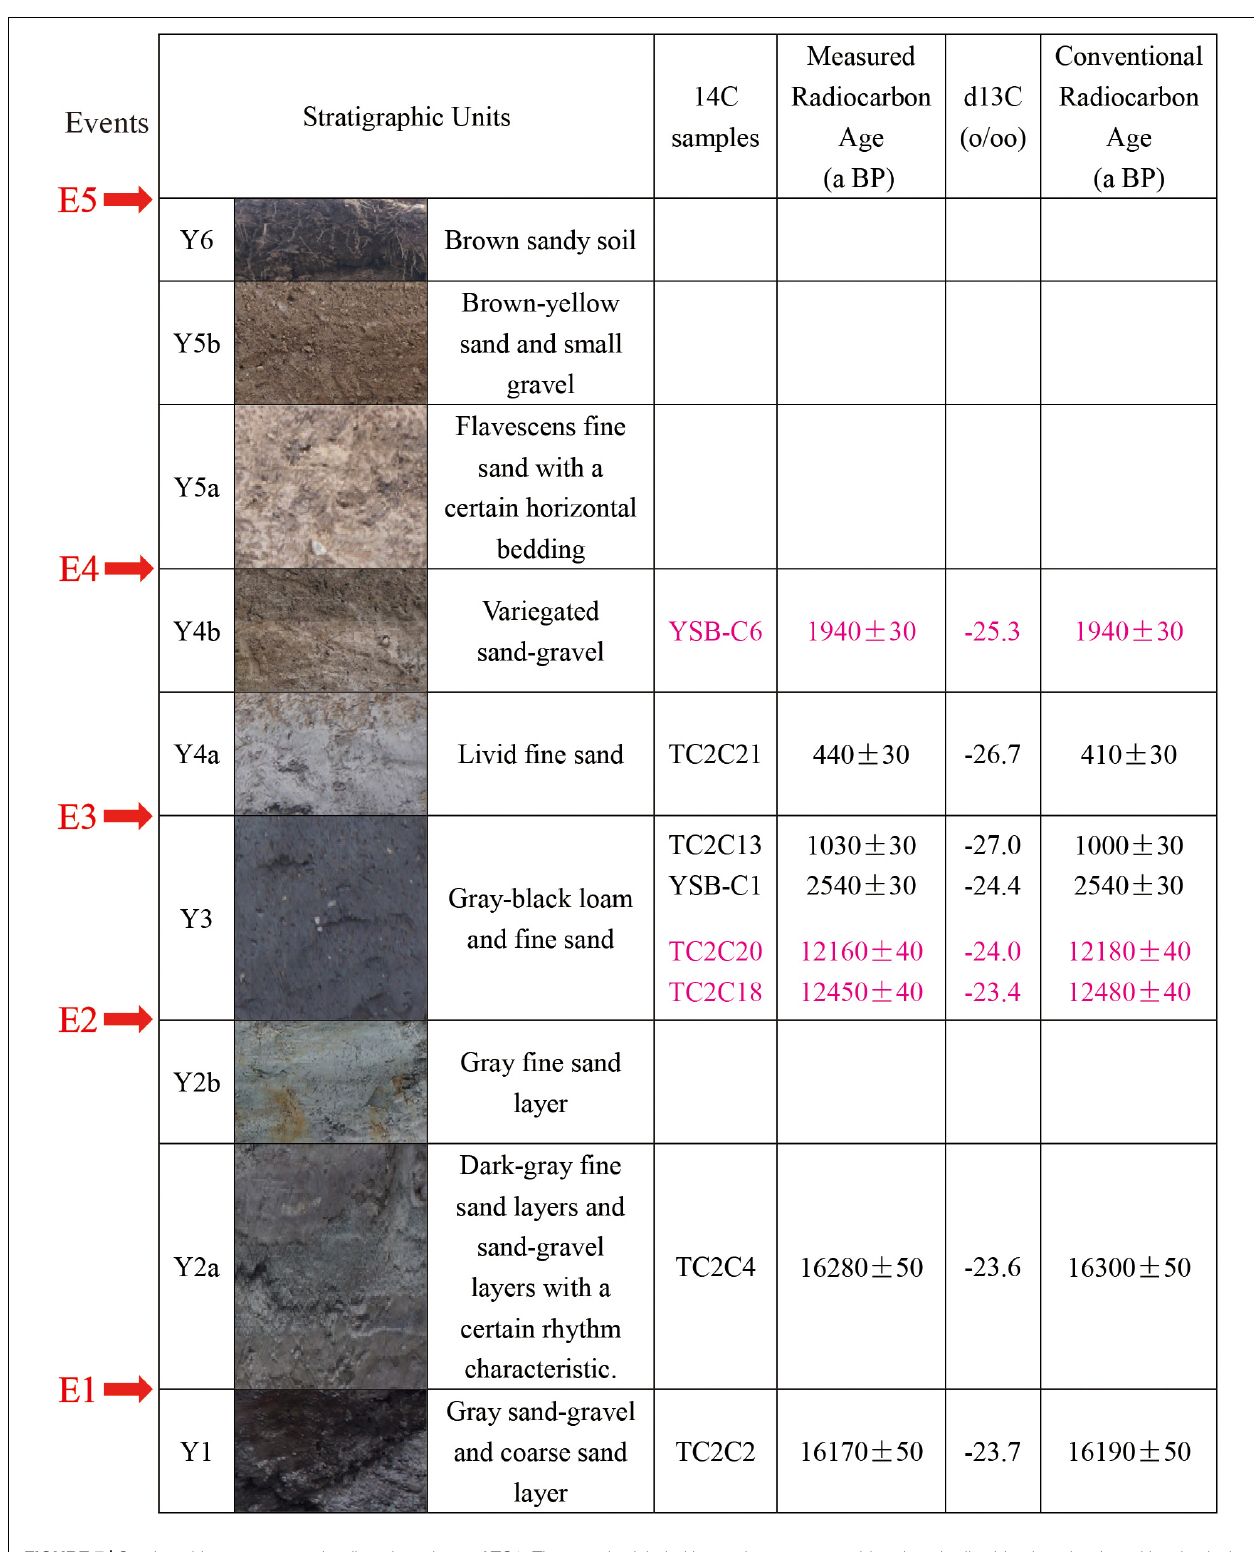
Frontiers in Earth Science |